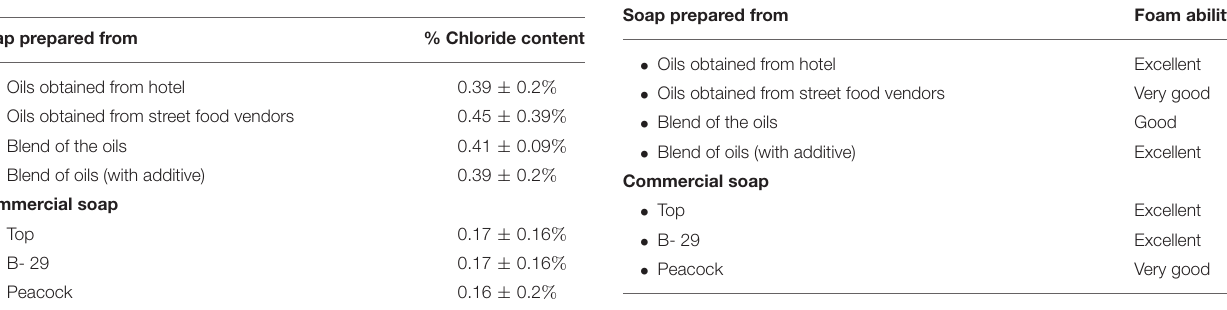
TABLE 6 | The percentage of chloride content of prepared and commercial soap products.